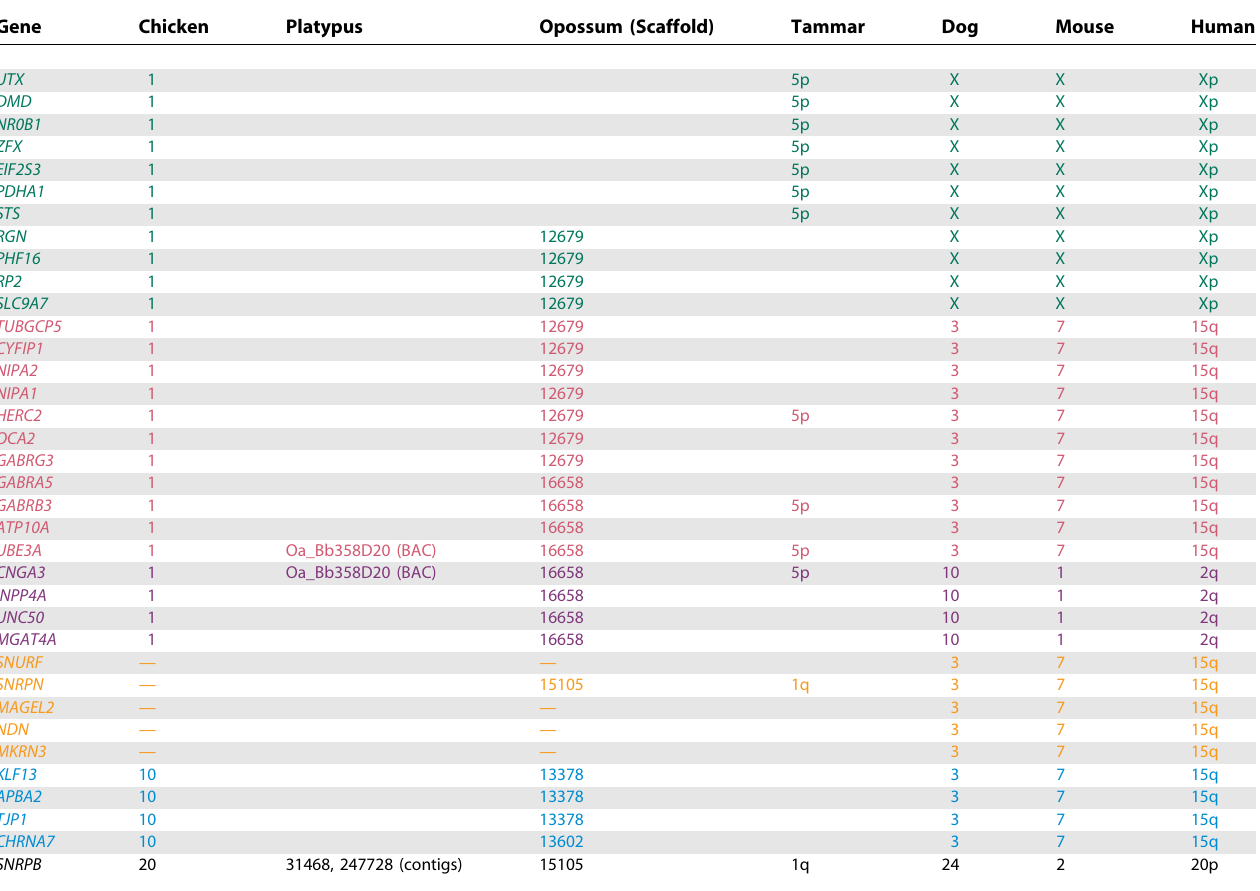
Table 1. Positions of Orthologs of Human PWS-AS Genes and Their Flanking Markers in Chickens and Three Groups of Mammals Gene